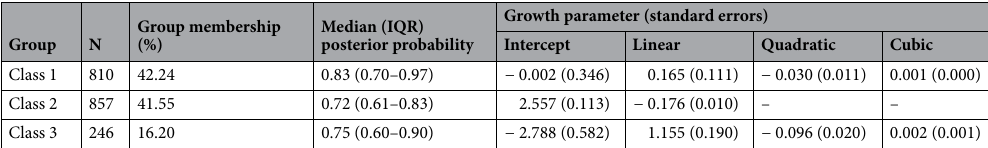
Table 2. Trajectory descriptions, median posterior probabilities and growth parameter among boys, CFPS. Three trajectories identified through latent class trajectory modeling with the TRAJ procedure using the censored normal model. The polynomials in age of Class 1 included linear, quadratic and cubic; the polynomials in age of Class 2 included linear; and the polynomials in age of Class 3 included linear, quadratic and cubic.